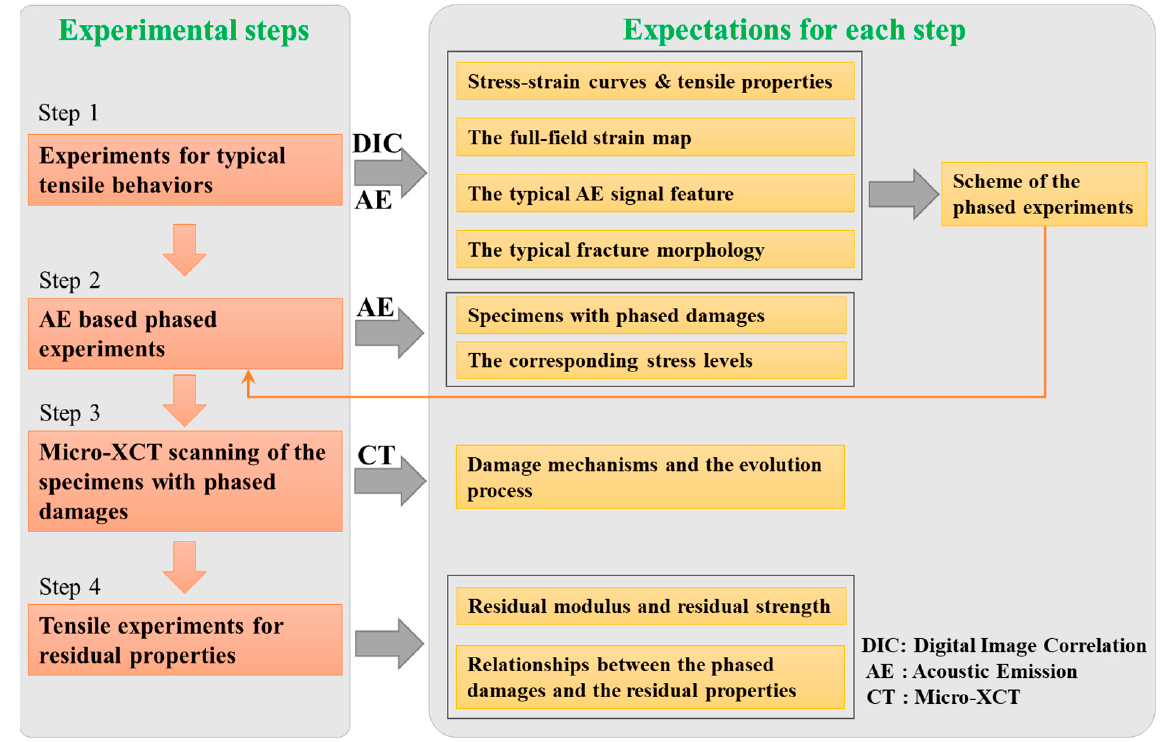
Figure 2. The flow chart of the 4-step experimental procedure.